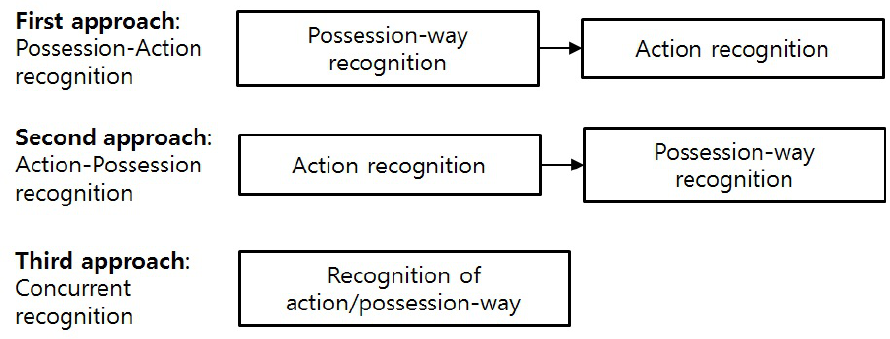
Figure 1. Three proposed